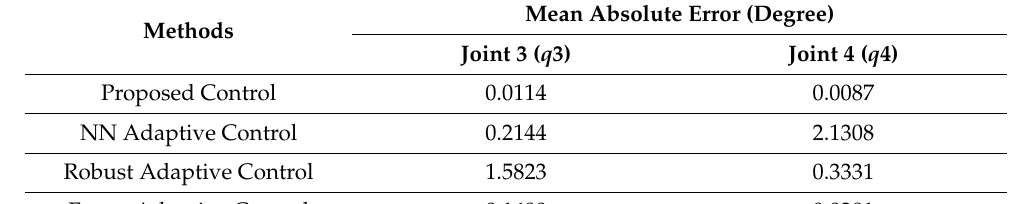
Figure 6. Tracking error.